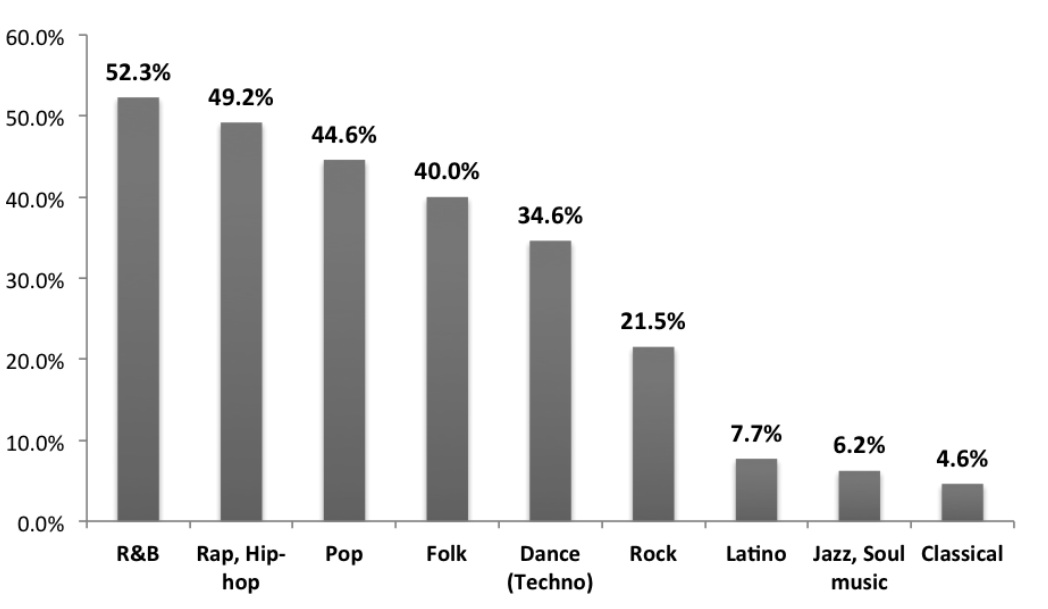
Fig. 3. What kind of music listen Bulgaria children.